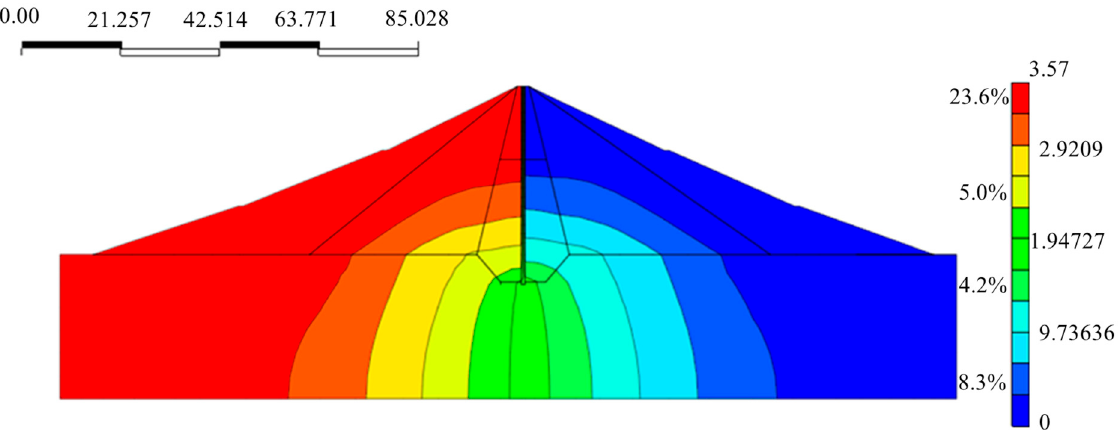
Figure 10. Isograms of pressure head for the main dam by the proposed method.